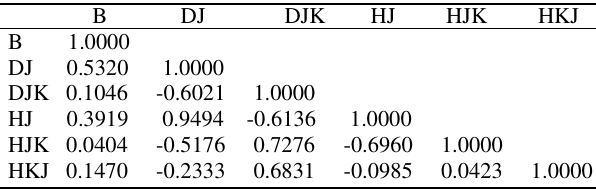
O) in ground state. 2 3